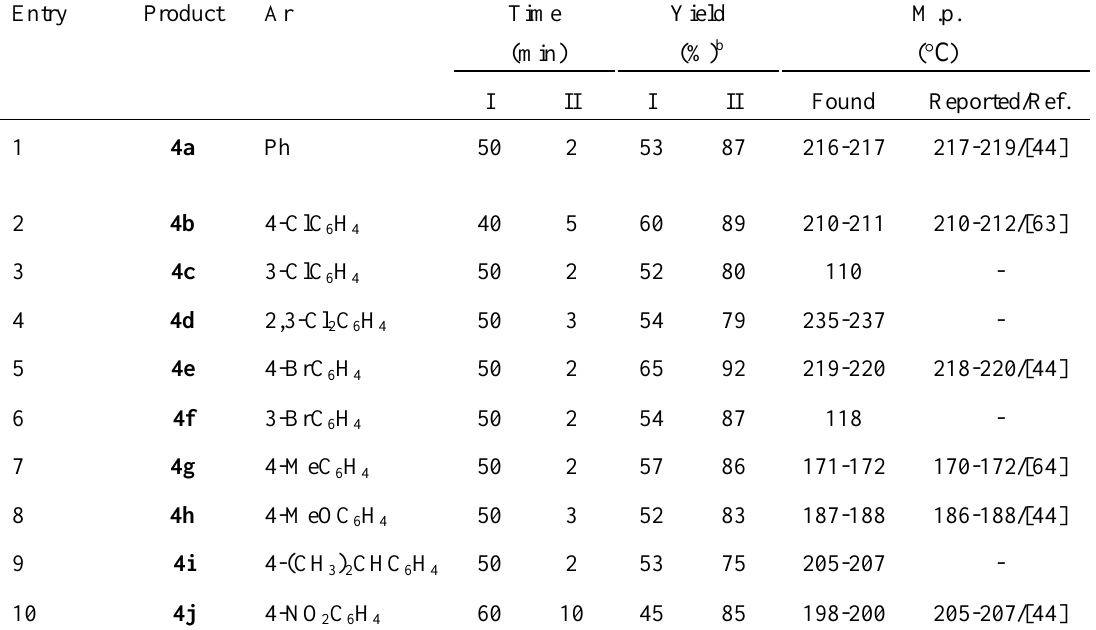
H NPs as Catalyst 3